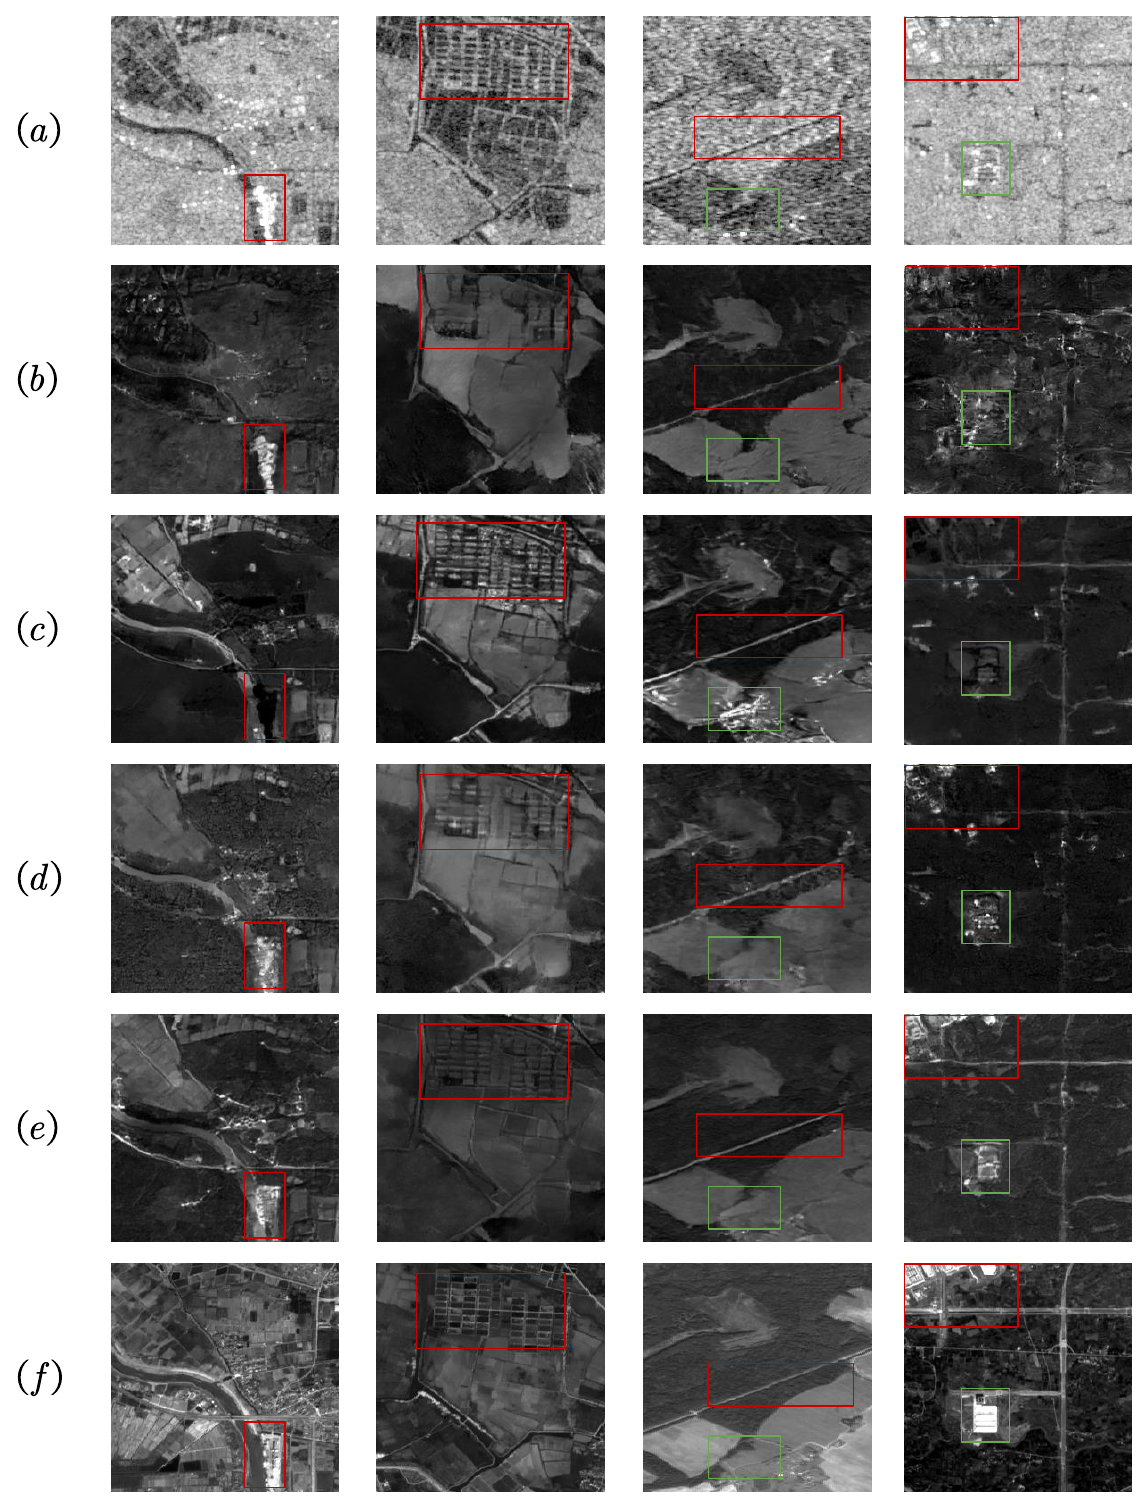
Figure 5. A visual comparison of different SAR-to-optical methods. The size of all images was 256 × 256. ( a ) SEN-1 SAR image. ( b ) Pix2pix. ( c ) CycleGAN. ( d ) S-CycleGAN. ( e ) EPCGAN. ( f ) SEN-2 optical